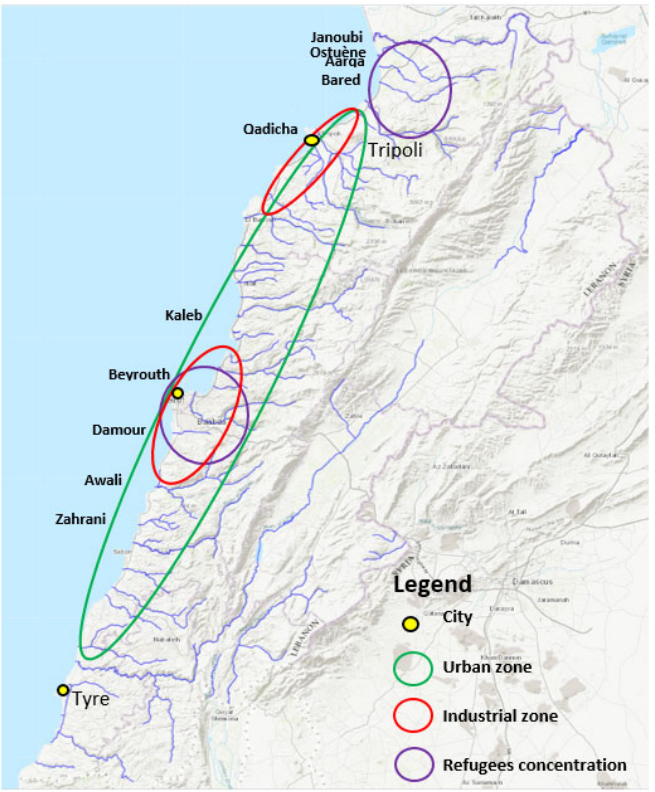
Figure 4. High anthropogenic impact locations. A map from “Rivers, Lebanon, 2012. https://maps.princeton.edu/catalog/stanford ‐ wn533df2039”. Web. 22 Feb. 2022 representing the Lebanese rivers, modified to show locations on the Lebanese cost of the largest industrial zones (Beirut and Tripoli), the highest urbanized area, and the location of refugees, according to the UNHCR, UN ‐ habitat 2014, and the UNRWA 2021 organizations.